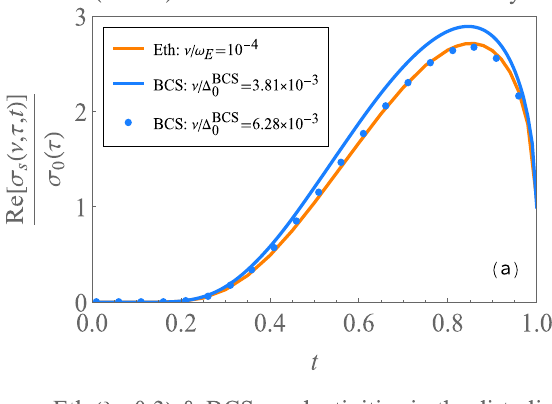
Fig. 4 The nuclear magnetic resonance (NMR) relaxation rate R s / R n in Eliashberg theory (Eth) versus reduced temperature t ≡ T / T c . Here, the electron – phonon coupling strength is λ = 1. The orange points are the numerical results obtained using Eq. (2.15), the blue curve is our analytical result (2.18), and the green curve is Fibich ’ s result (2.23). The lines merely connect the data